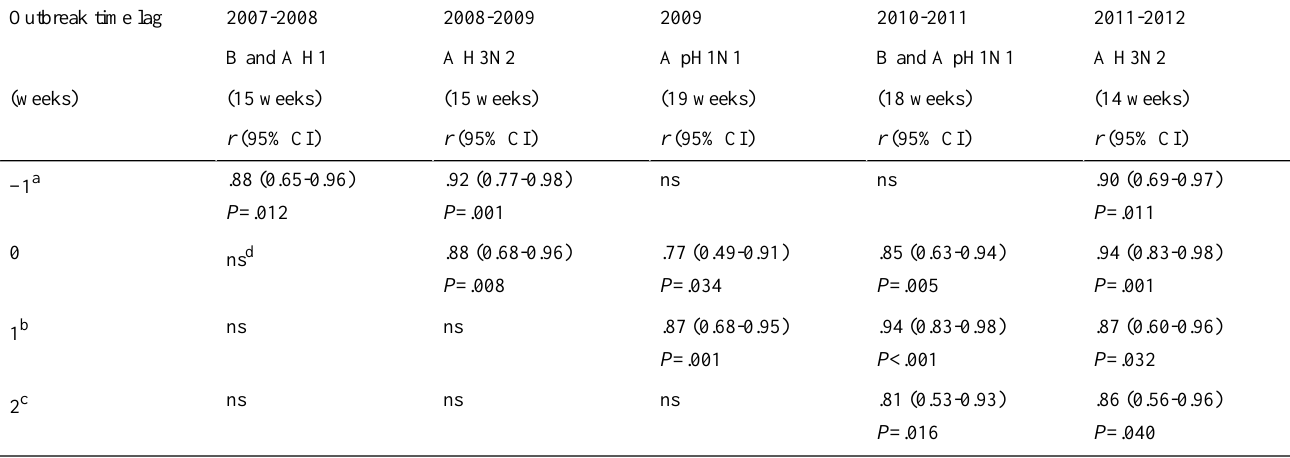
Table 4. Associations on a weekly basis between GFT data and telenursing call data displayed by the correlation coefficient r (95% CI), for the five influenza outbreaks observed in Östergötland county, Sweden, during the study period